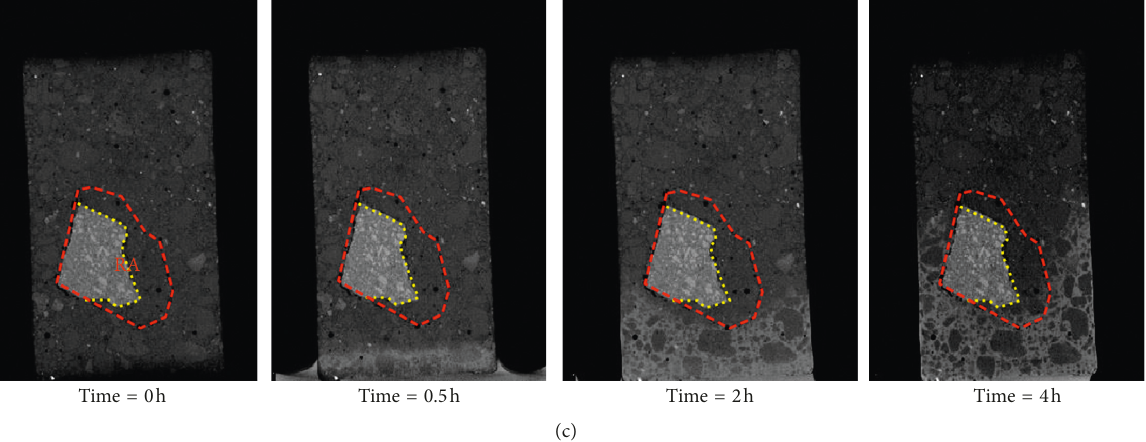
Figure 2: Chloride ion penetration paths in RAC with different W/C ratios: (a) W/C ratio ratio (cid:31)